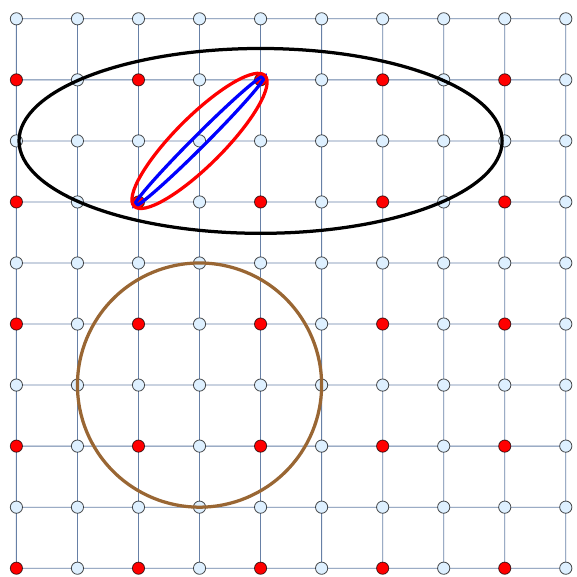
¯ ¯ Figure 1 . The figure depicts the ( h 0 , h 0 ) plane. The lines parallel to h 0 = h 0 line are fixed spin lines. The lines perpendicular to fixed spin lines are fixed ∆ lines. Suppose, we find an example such that all the operators appearing in the OPE of two O operators are separated by δh = δ ¯ h = 2 . The red dots in the figure depicts them. The Tauberian analysis tells us that the brown circle ( r = 2 ) and √ the black ellipse (semi-minor axis > 2 ) will always have some operators within it, as the center approaches infinity. The black ellipse can be rotated by π/ 4 , the same result holds. To obtain the √ red and the blue ellipse, one has to take the black ellipse with semiminor axis of length 2 and squeeze the other axis, this can only be achieved by using T invariance in the fixed spin analysis. In the limit, the blue ellipse degenerates into a line segment of length (defined as Euclidean distance √ on the ( h 0 , ¯ h 0 ) plane) 2 2 (or in terms of ∆ , the length of the segment is δ ∆ = 4 ). This is the bound on the gap that we obtain from fixed spin Tauberian analysis and this also proves the optimality of our bound, since we can not push the bound to a smaller value. An explicit example of such